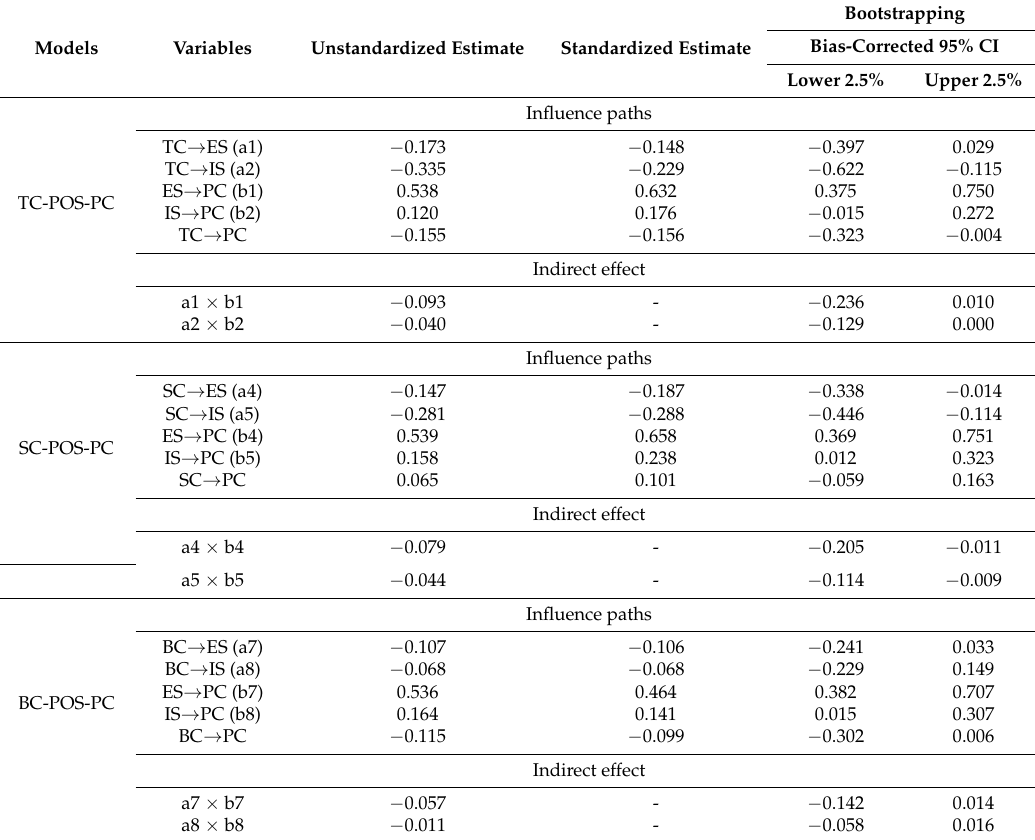
Table 9. The direct effects testing results of multiple mediation models.